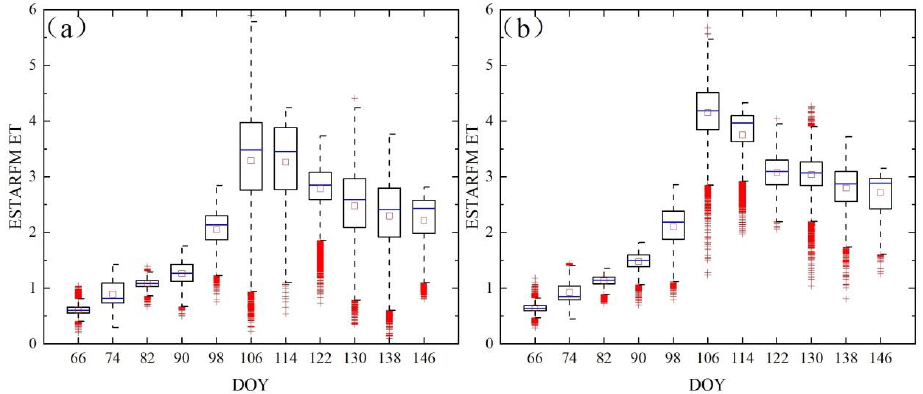
Figure 6. Temporal variation in ESTARFM evapotranspiration (ET) during the main growth period of winter wheat in ( a ) rain-fed areas and ( b ) irrigated areas.